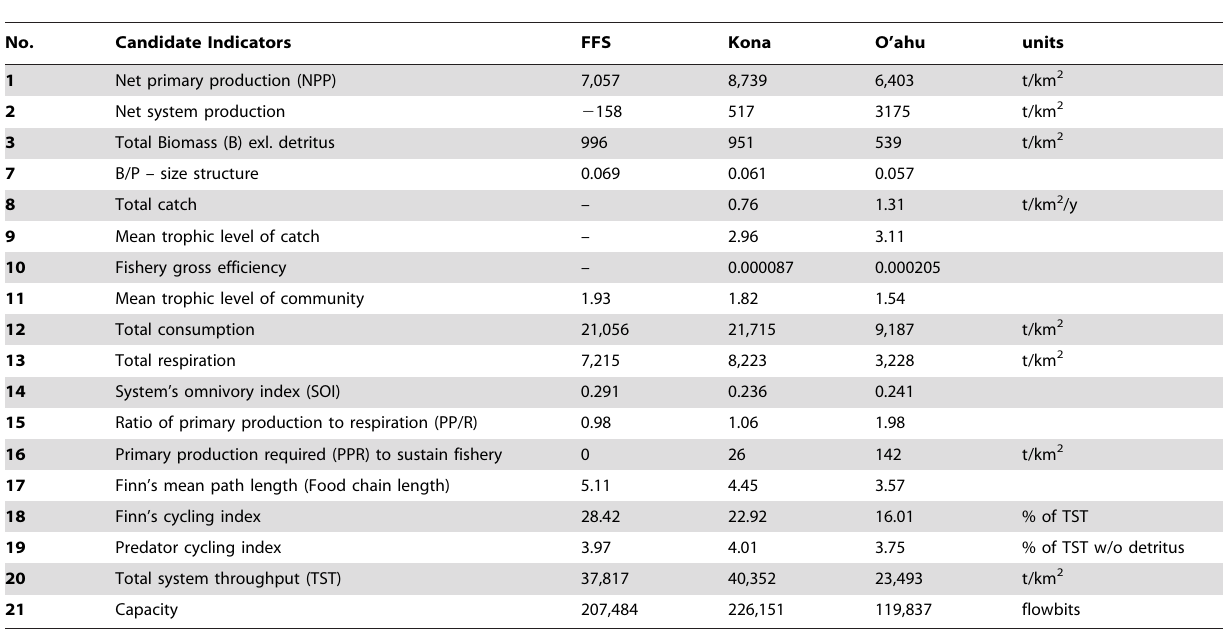
Table 4. Ecopath derived values for candidate indicators of fishery effects on coral reef ecosystems.